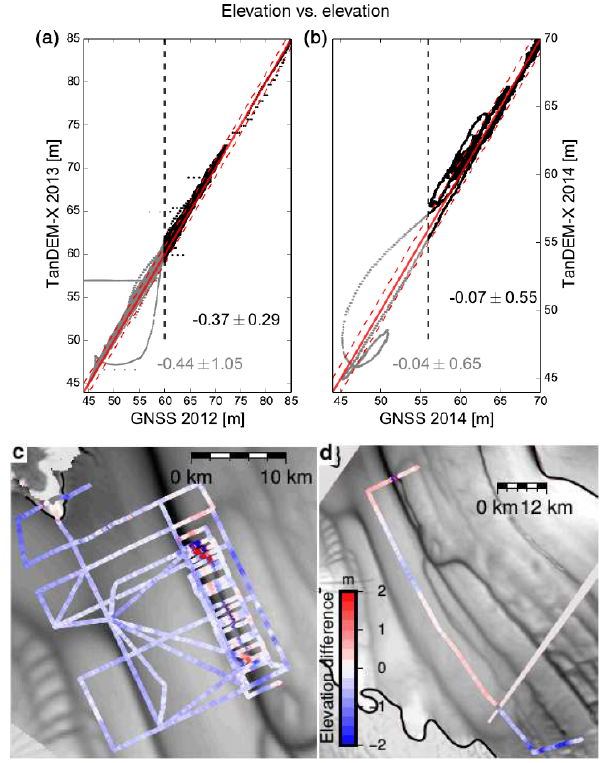
Figure 9. (a–b) Comparison between GNSS 2012 and TandDEM- X 2013 and between GNSS 2014 and TanDEM-X 2014, respec- tively. The GNSS data are located in Fig. 1. The grey points, on the left on the vertical dashed lines, lie in ice shelf channels and are shown in light blue and light red in the profiles in Fig. 1. The plain and dashed red lines show the perfect equality between the two elevations datasets and the ± 1m difference, respectively. (c– d) Spatial variations in elevation differences between GNSS 2012 – TandDEM-X 2013 and GNSS 2014 – TanDEM-X 2014, respec- tively. Background is from TanDEM-X